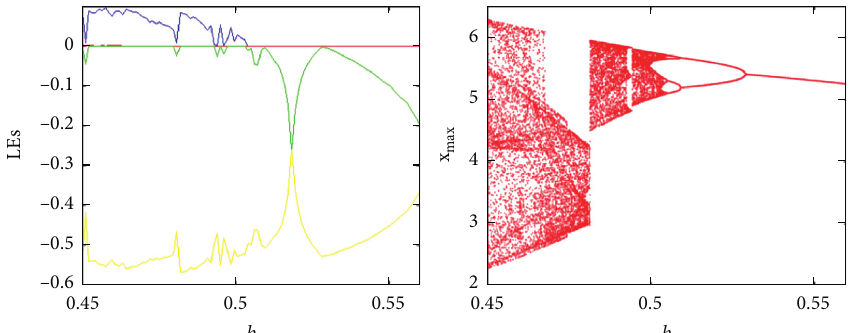
Figure 6: Lyapunov exponent spectrum and bifurcation diagram of system (1) with (a) � 0.8, (c) � 1, (d) � 0.1 and initial condition IC � (0.01, 0.01, 0, 0), when (b) varies in [0.45, 2.5. Amplitude Control. For a dynamical system, there are Furthermore, from the bifurcation diagram of x in max various parameters influencing the dynamics, some of which Figure 10, system (1) switches its dynamics from period � 0.02. This discontin- are bifurcation ones and some define the geometric prop- to chaos at the breakpoint of x 0 erties. In the chaotic system with only one linear or non- uous bifurcation mode is also proved by Figure 12, where linear term, the coefficient of it may play the role of system (1) switches the oscillation from a limit cycle to amplitude control. Here, after the tertiary magnetron chaos. Note that all the bifurcation is realized by the memristor was introduced into the Jerk system, the new initial condition, and therefore the hidden bifurcation chaotic system introduces only a nonlinear term with a occurs in the initial space indicating a new regime of parameter for adjusting the amplitude. When a � 0.8, b � 0.5, multistability.